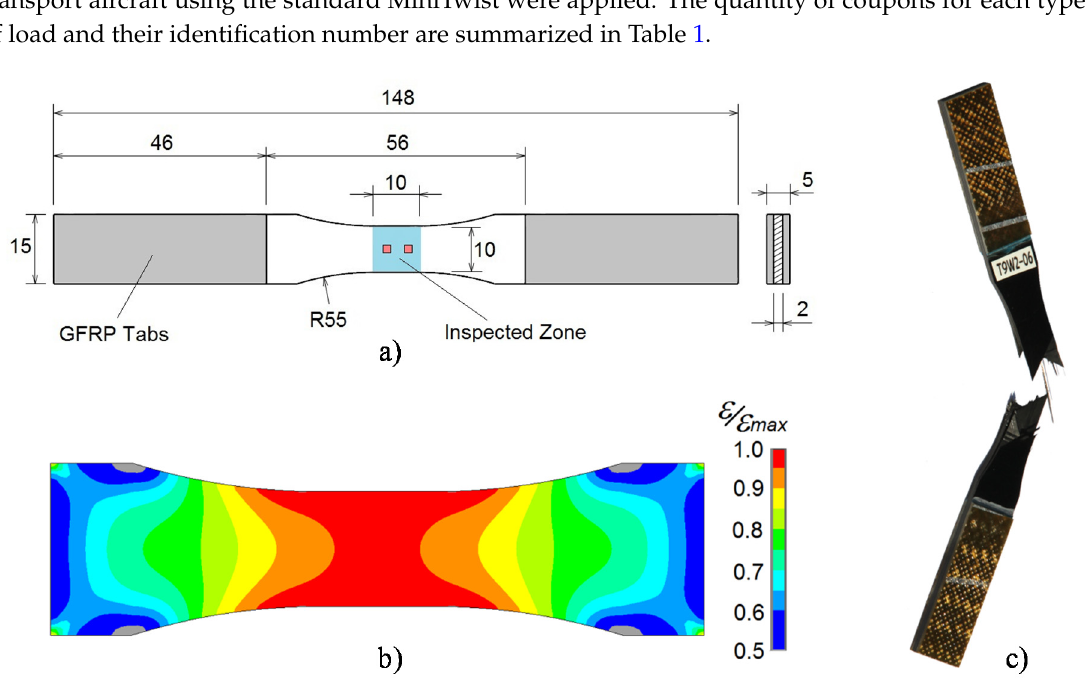
Figure 2. ( a ) Coupon geometry and principal dimensions (mm); ( b ) Normalized strain distribution in the direction of the tensile load by finite element analysis, showing less than 5% of strain gradient in the optical measurement zone; ( c ) Typical failure of a coupon under tensile fatigue loads. Table 1. Quantity of specimens and type of load used for the fatigue test.